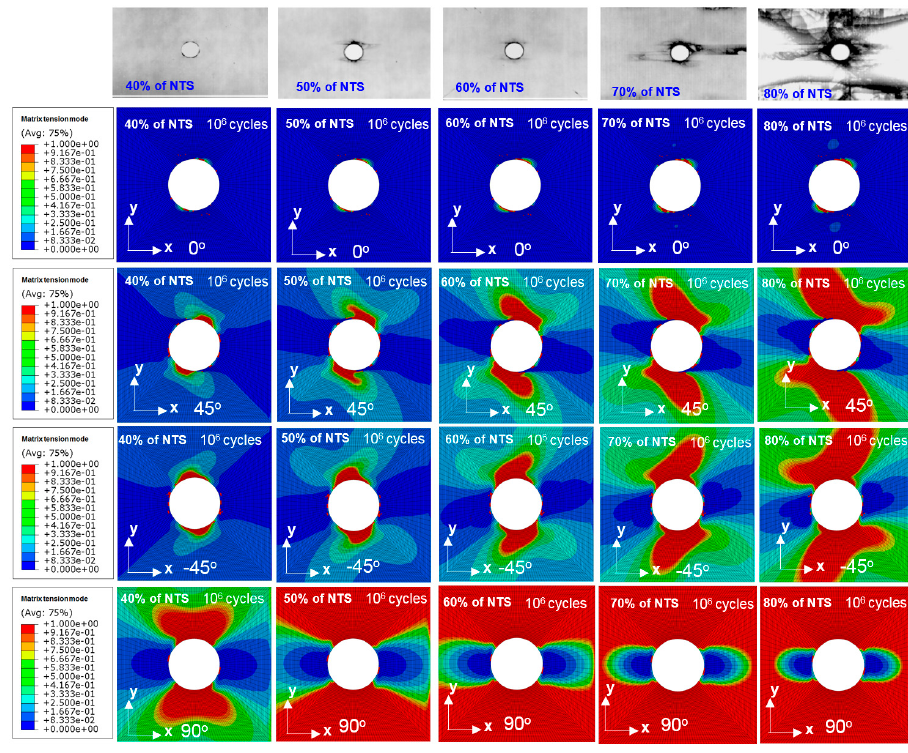
Figure 12. Matrix tension failure index after 10 6 cycles in the quasi-isotropic OHT specimen. J. Compos. Sci. 2018 , 2 , x FOR PEER REVIEW